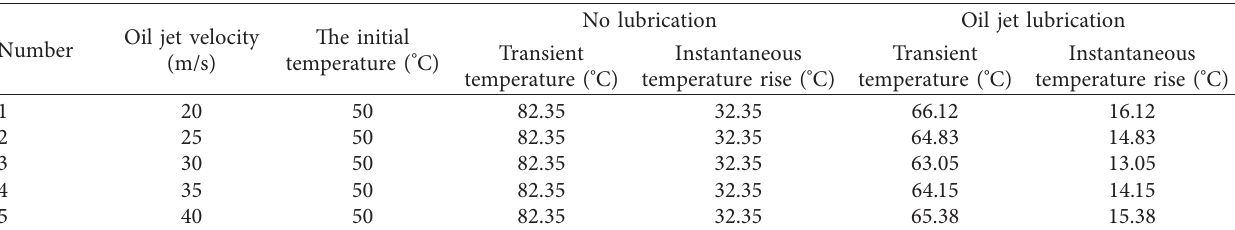
Table 4: Simulation results at different oil jet